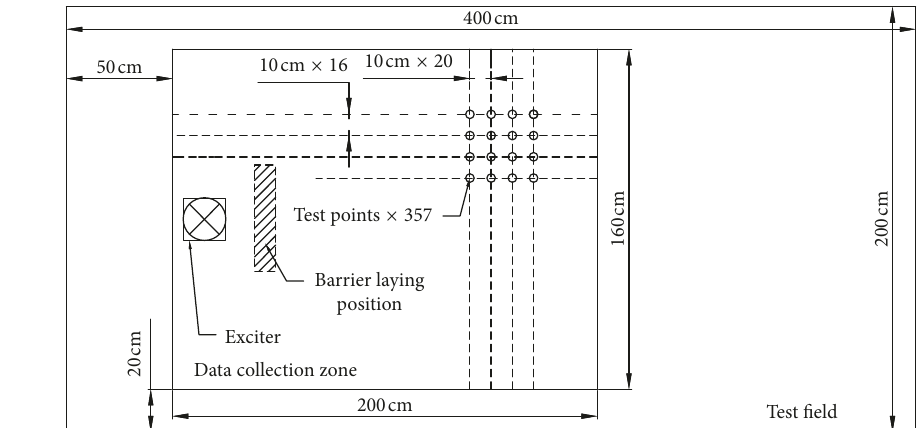
Figure 5: Test layouts. Table 3: The schedule working conditions.